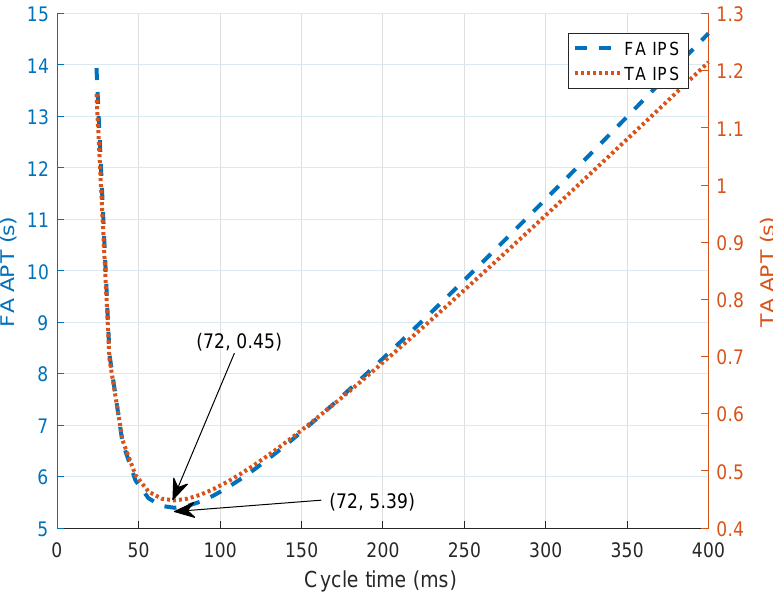
Figure 13. Reduction of APT in the overlap region through the use of a receiver defined threshold angle (TA) instead of the conventional full angle (FA) for 4-bit packets in (21).